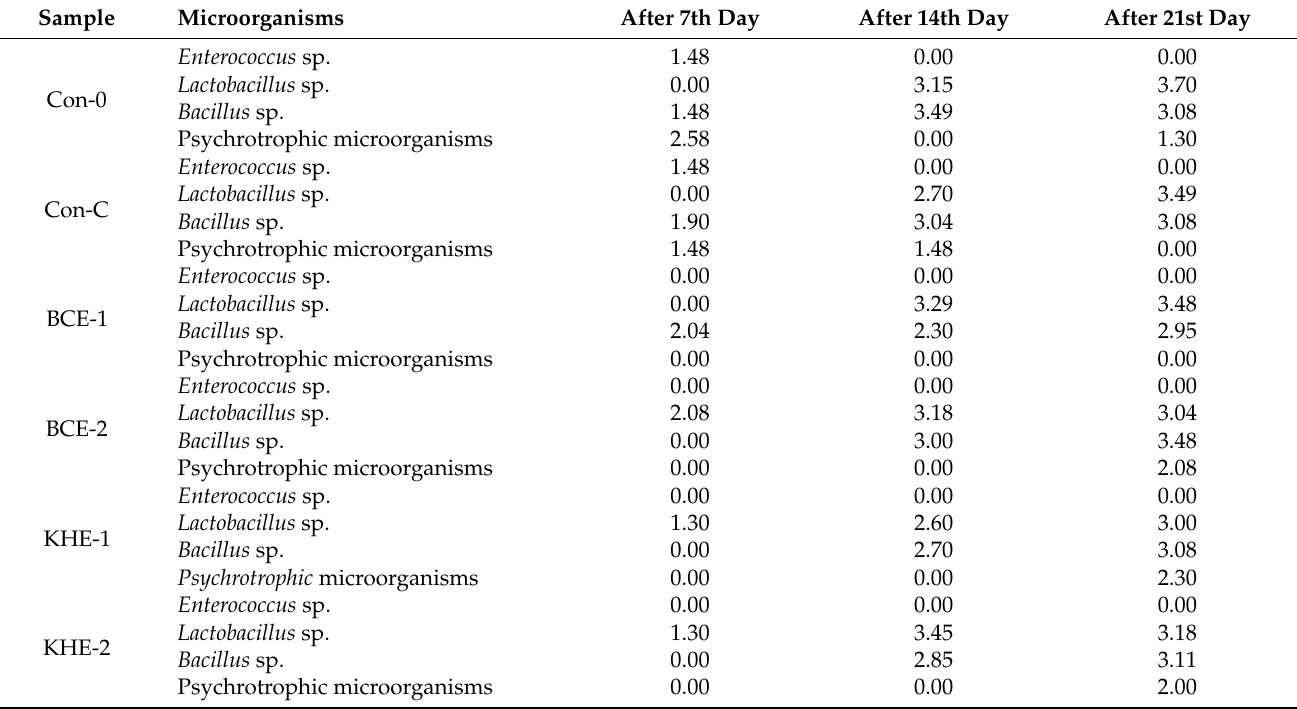
Table 5. Results of microbial examination of